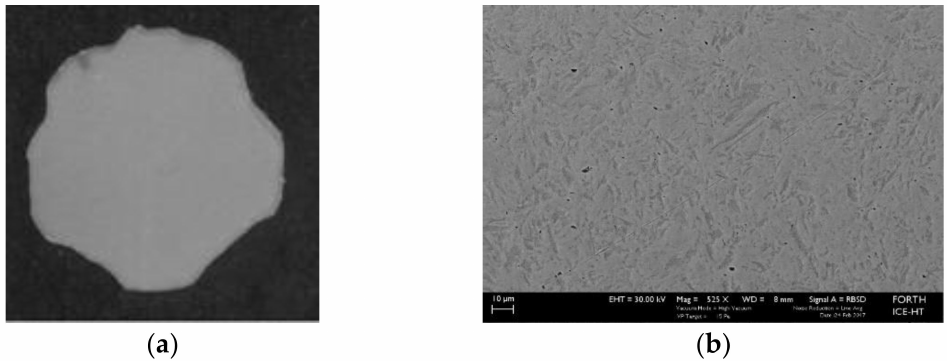
Figure 3. Homogeneous microstructure ( b ) in a cross section of Dual Phase F rebar ( a ).